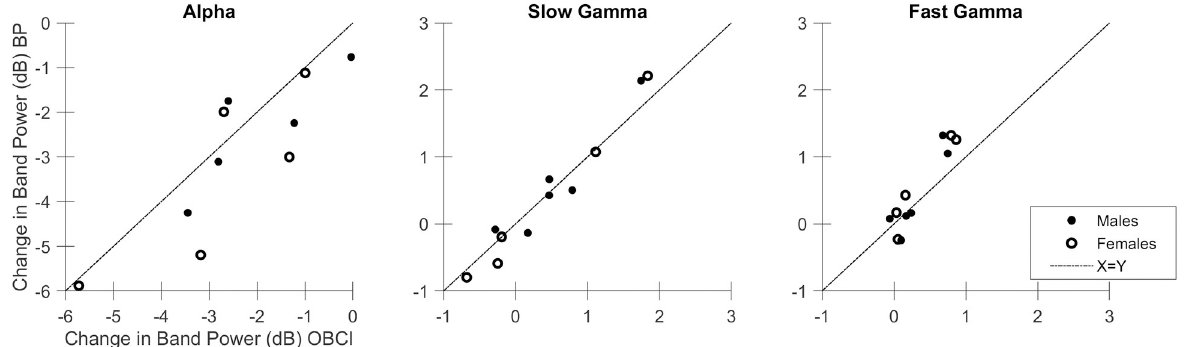
Fig 4. Comparison of change in Band Powers of OpenBCI and Brain Product recordings. Change in band power from baseline in stimulus period of alpha, slow gamma and fast gamma oscillations recorded using OpenBCI ( x axis ) and Brain Products ( y axis ) for males ( filled circles ) and females ( open circles ). Dashed line indicates identity